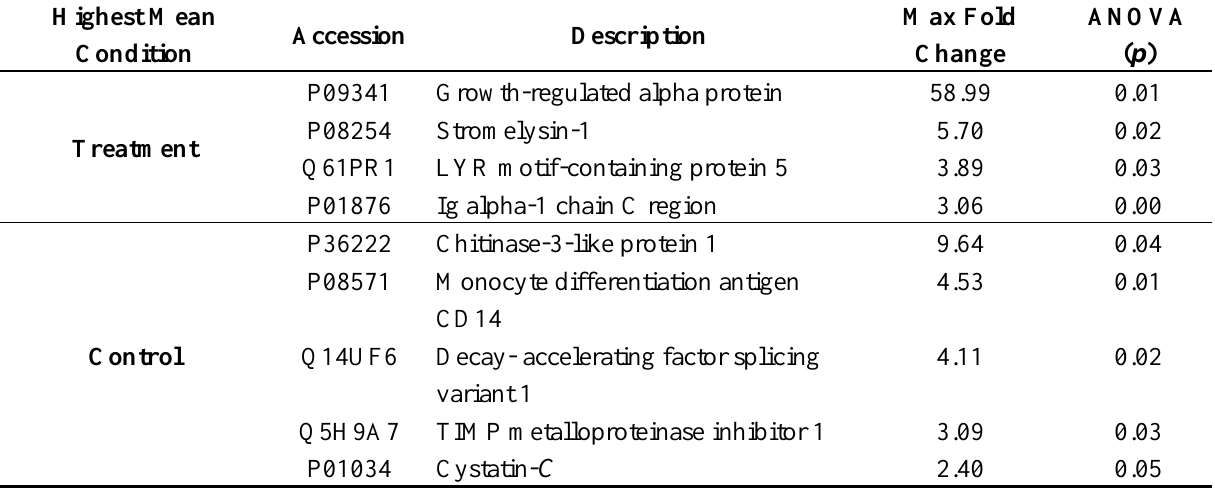
Table 1. A number of differentially expressed proteins were identified by Progenesis™ LC-MS software. Proteins shown were identified with ≥2 unique peptides and with a >2-fold change in normalised